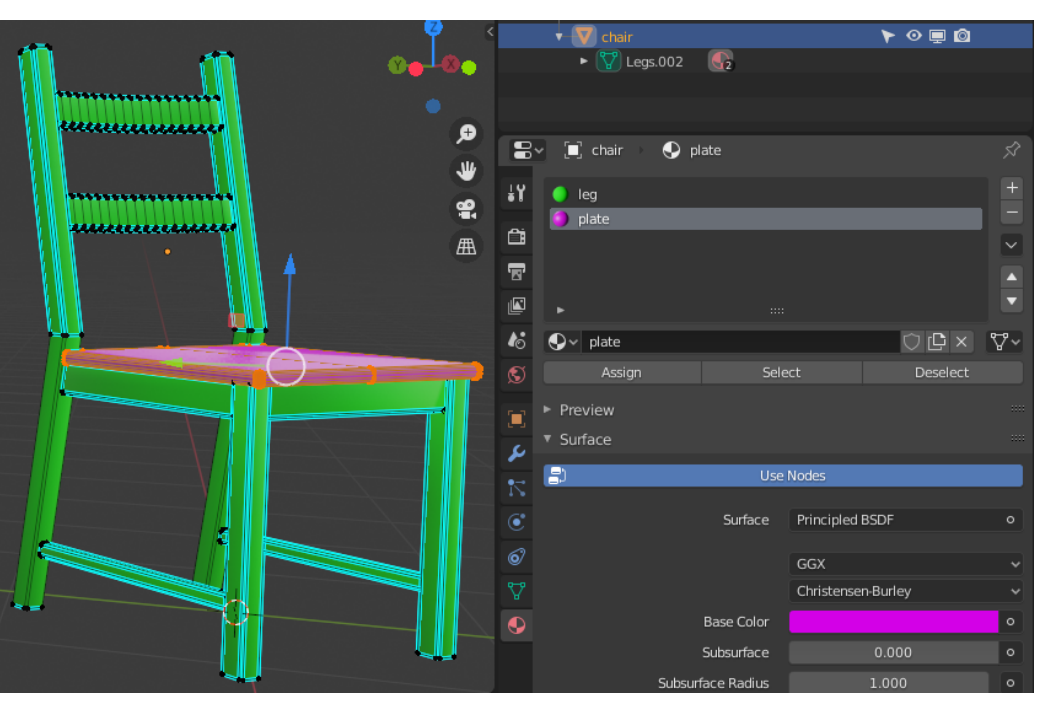
Figure 10. On the left half of the image you can see a chair object in edit mode. All points and lines belonging to the chair surface were selected and classified using the button for assigning a material. The chair legs were also assigned to a material. The group affiliation is defined by the respective material